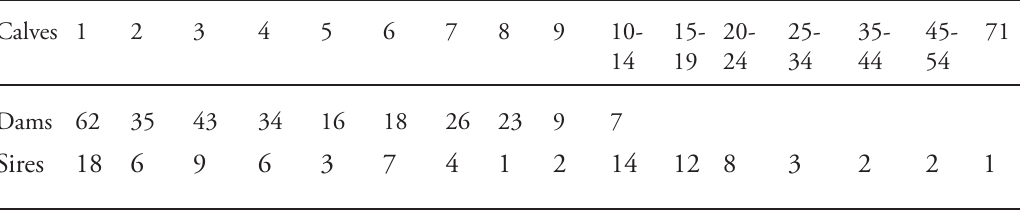
Table 1. The distribution of dams and sires over progeny in the Kutuharju pedigree data in the years 1987–2011.